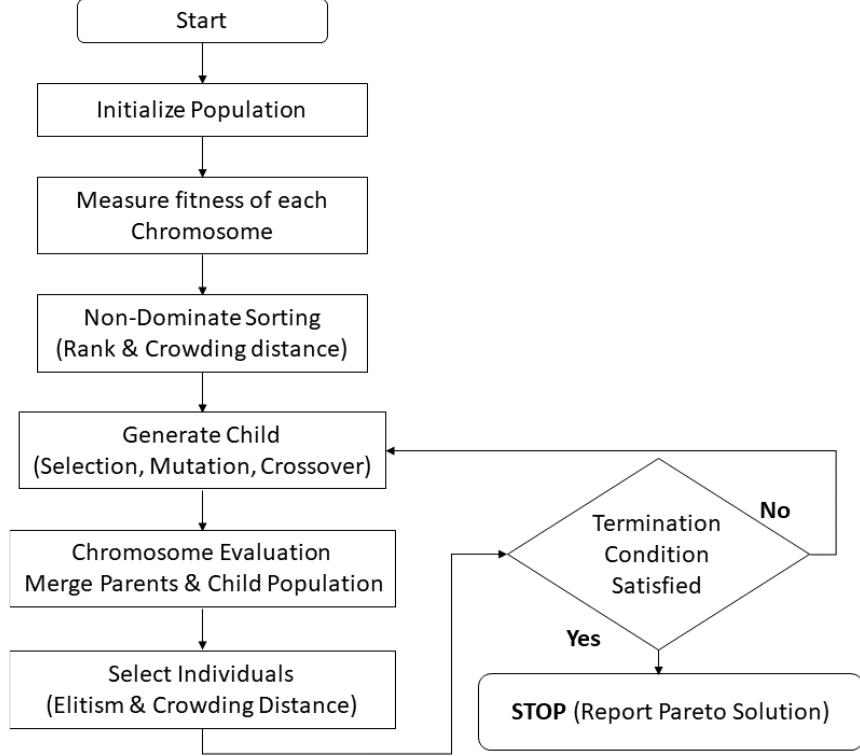
Figure 3. Flowchart of MNSGA.